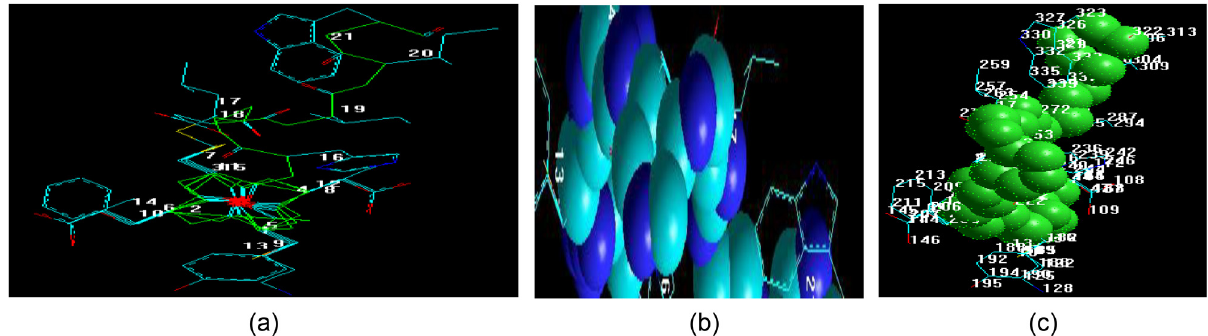
Figure 5: ET - I model backbone views; ( a ) backbone holding the side structures, loop area, and backbone atoms seen in green color; ( b ) backbone as ball - model holding the residues; ( c ) residue atoms distribution around backbone ’ s green model.